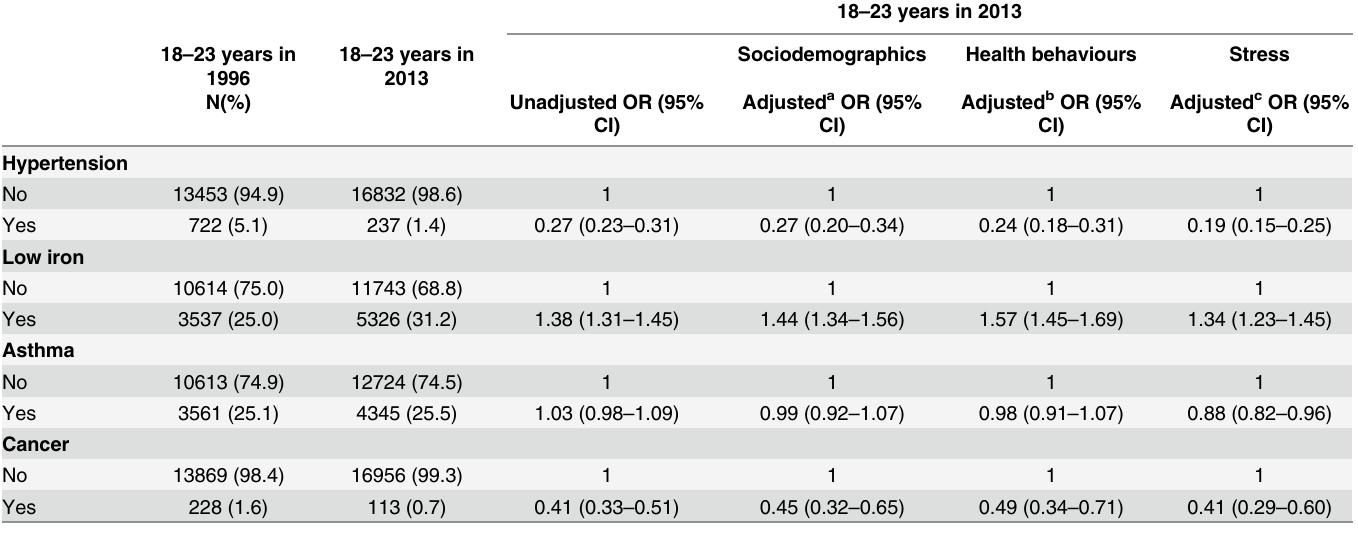
Table 5. Comparison of chronic conditions between two cohorts of young women aged 18 to 23 years in 1996 and in 2013. Odds ratios for partici- pants in 2013 compared to participants in